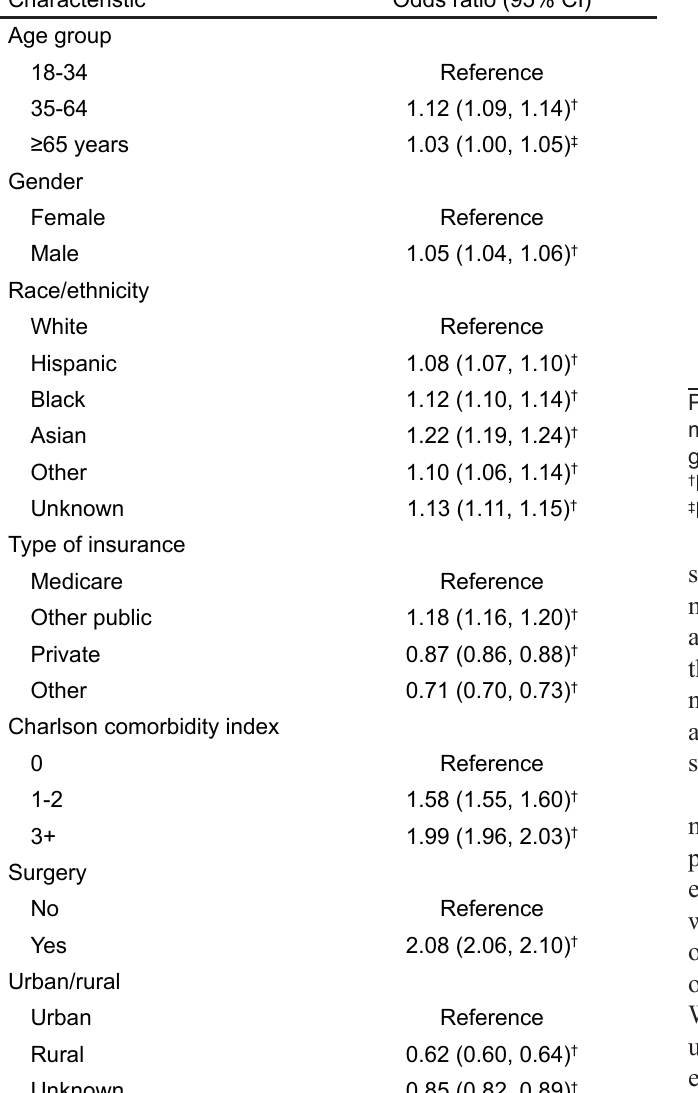
Table 4. Risk factors for prolonged acute mechanical ventilation in California, 2000-2009.